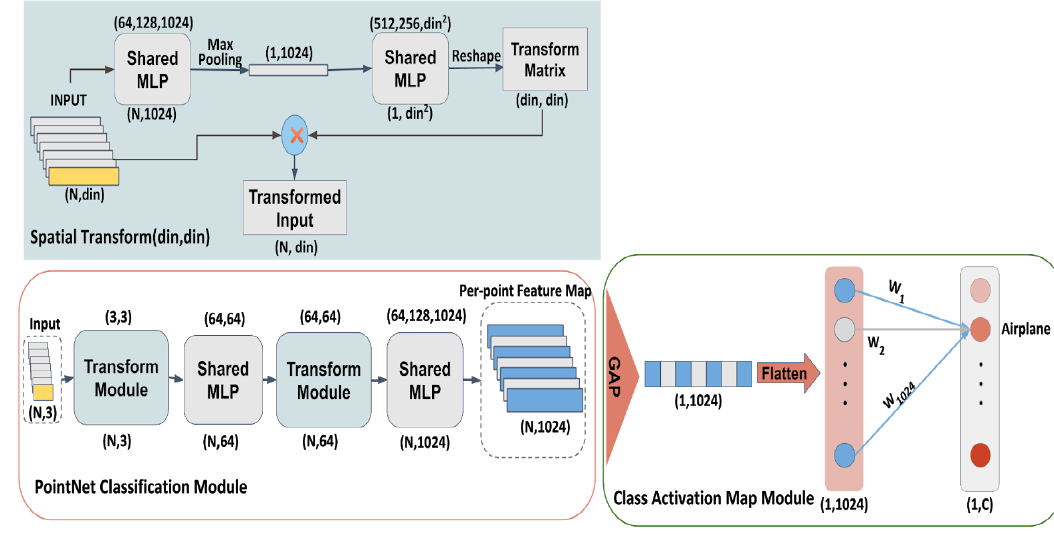
Figure 4. Illustration of PointNet-3DCAM architecture, including three parts: Spatial Transform Module, PointNet Classification Architecture, and class attentive weight computing